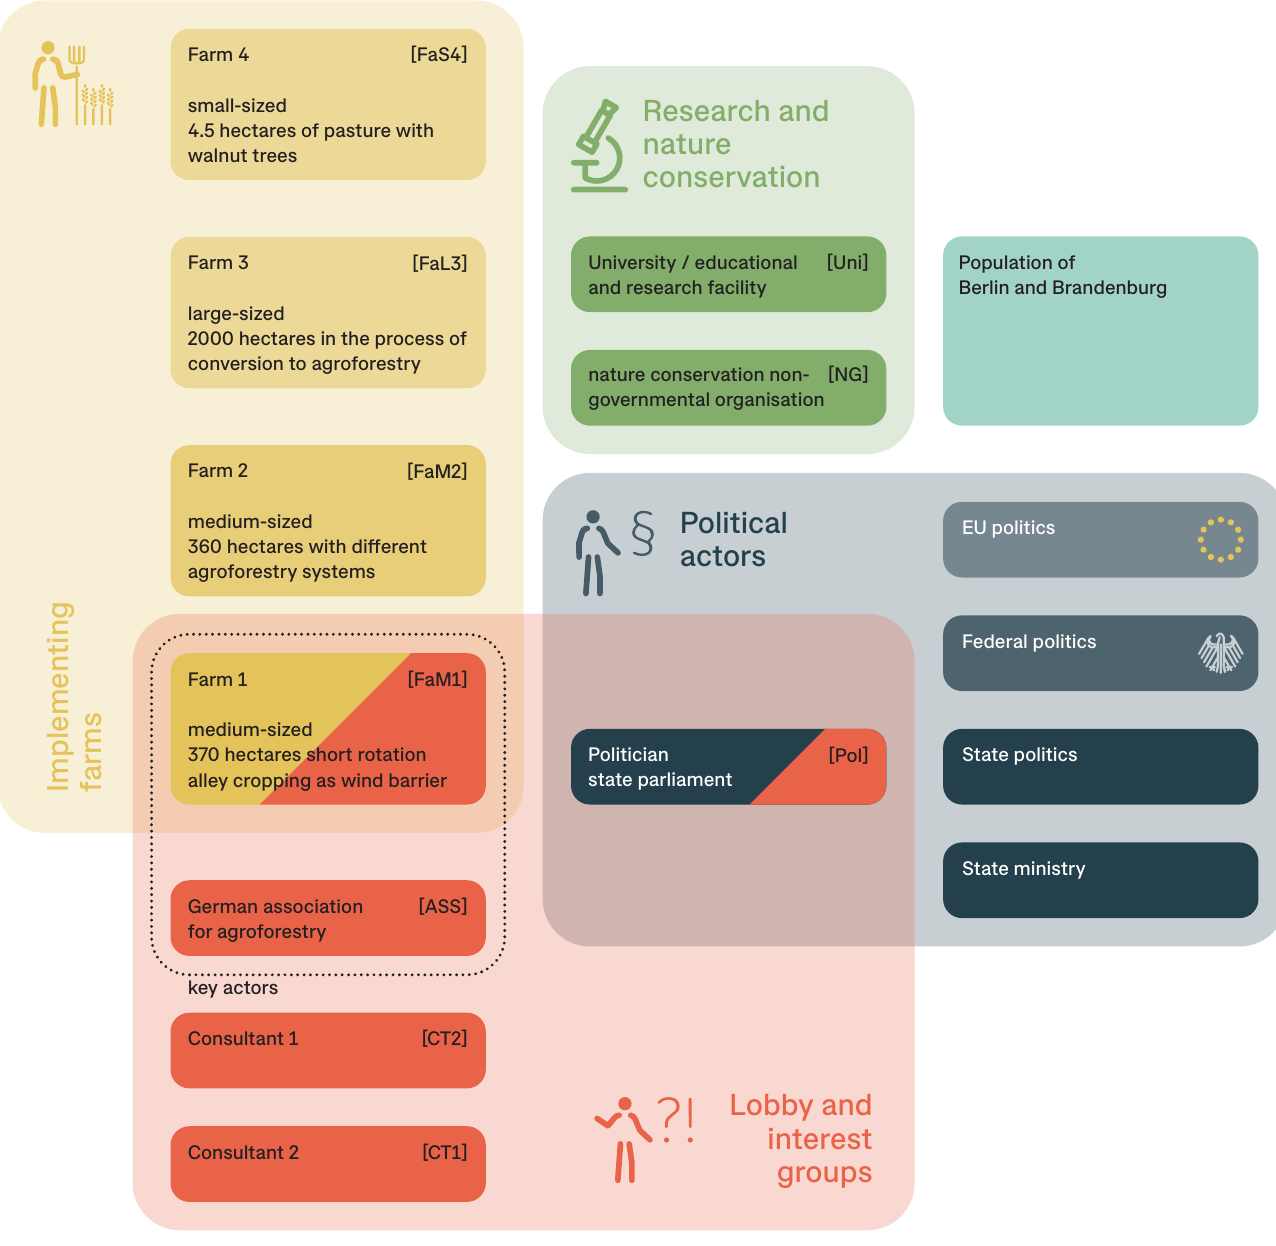
Figure 2. Networking and relationship map of the interviewed key